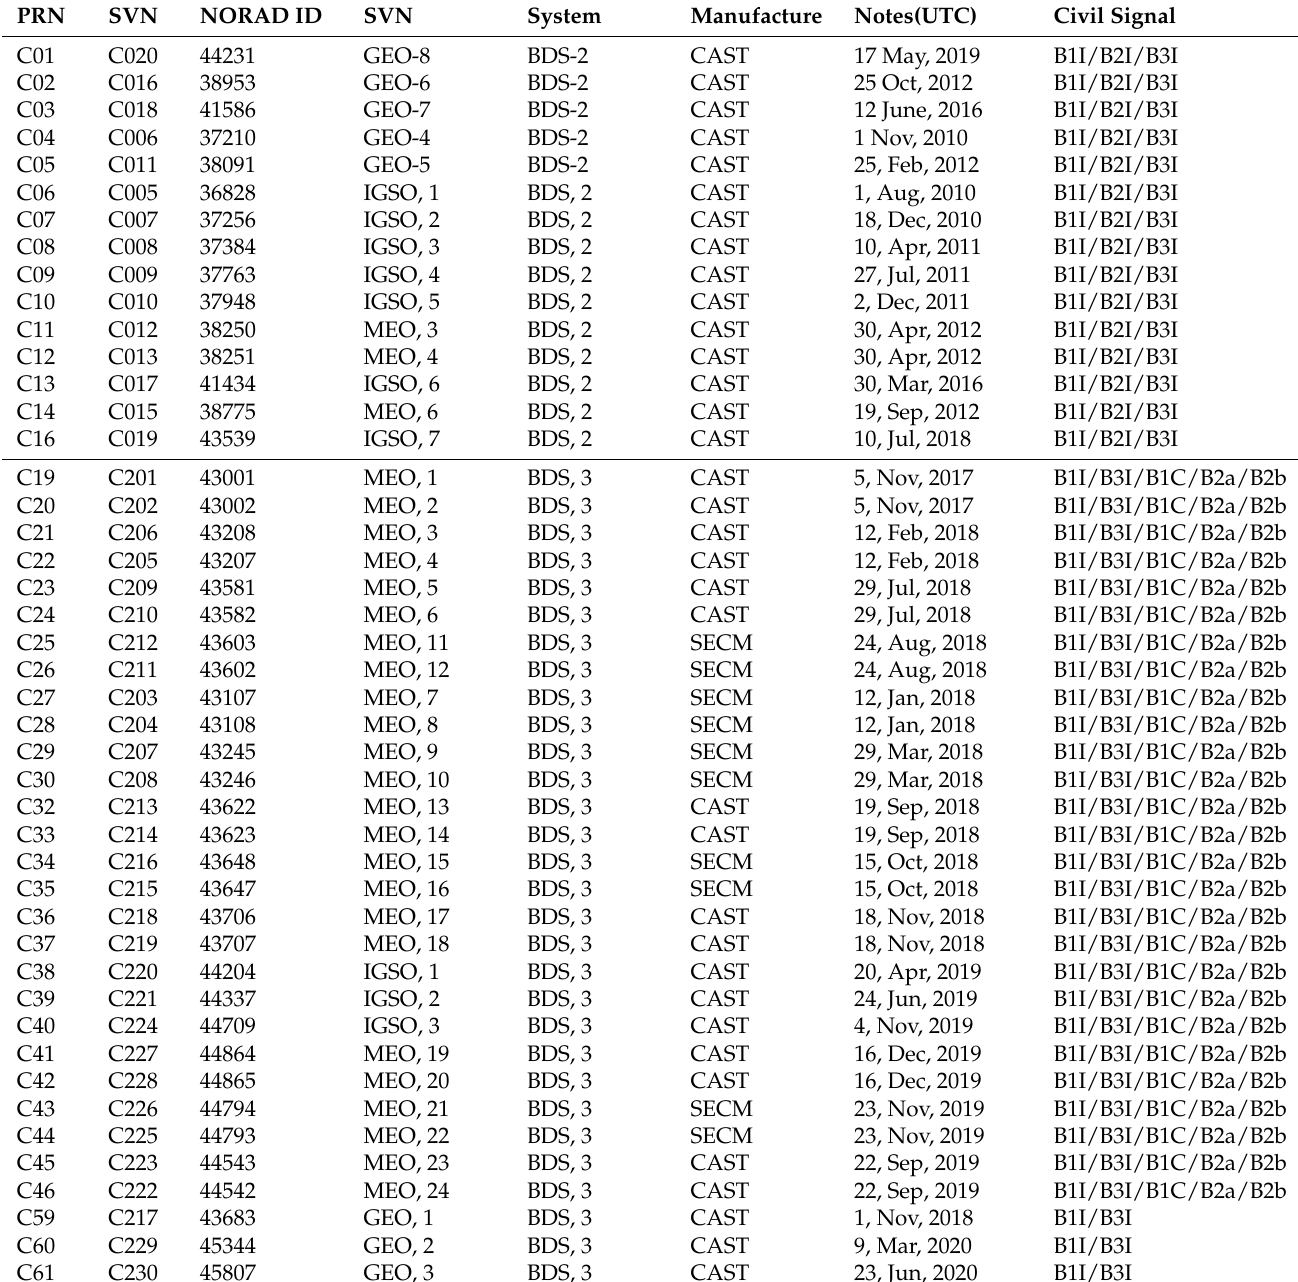
Table 1. The BeiDou navigation satellite system (BDS) satellite’s information (www.csno-tarc.cn/en/system/constellation, up to June